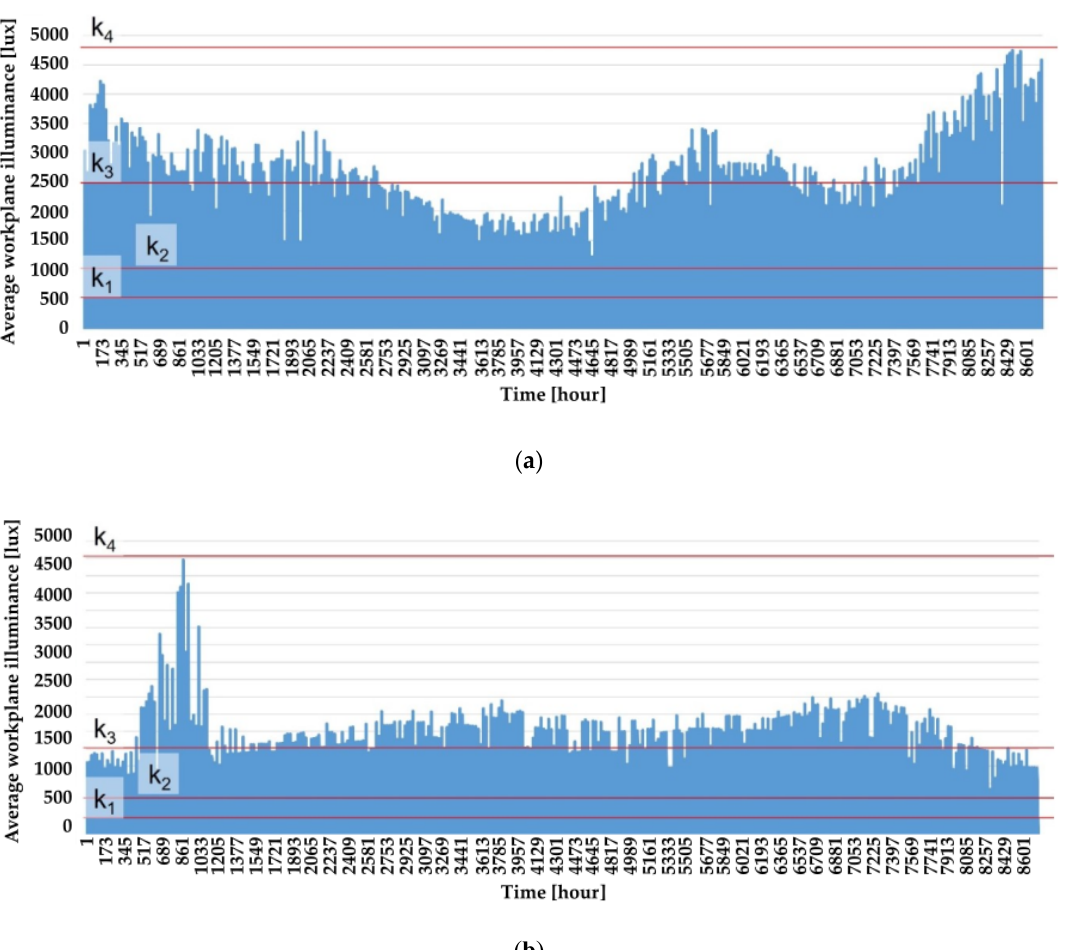
Figure 10. Time series of the average workplane illuminance in the ( a ) east and ( b ) west zones, and the resulting scenarios k 1 until k 4 .